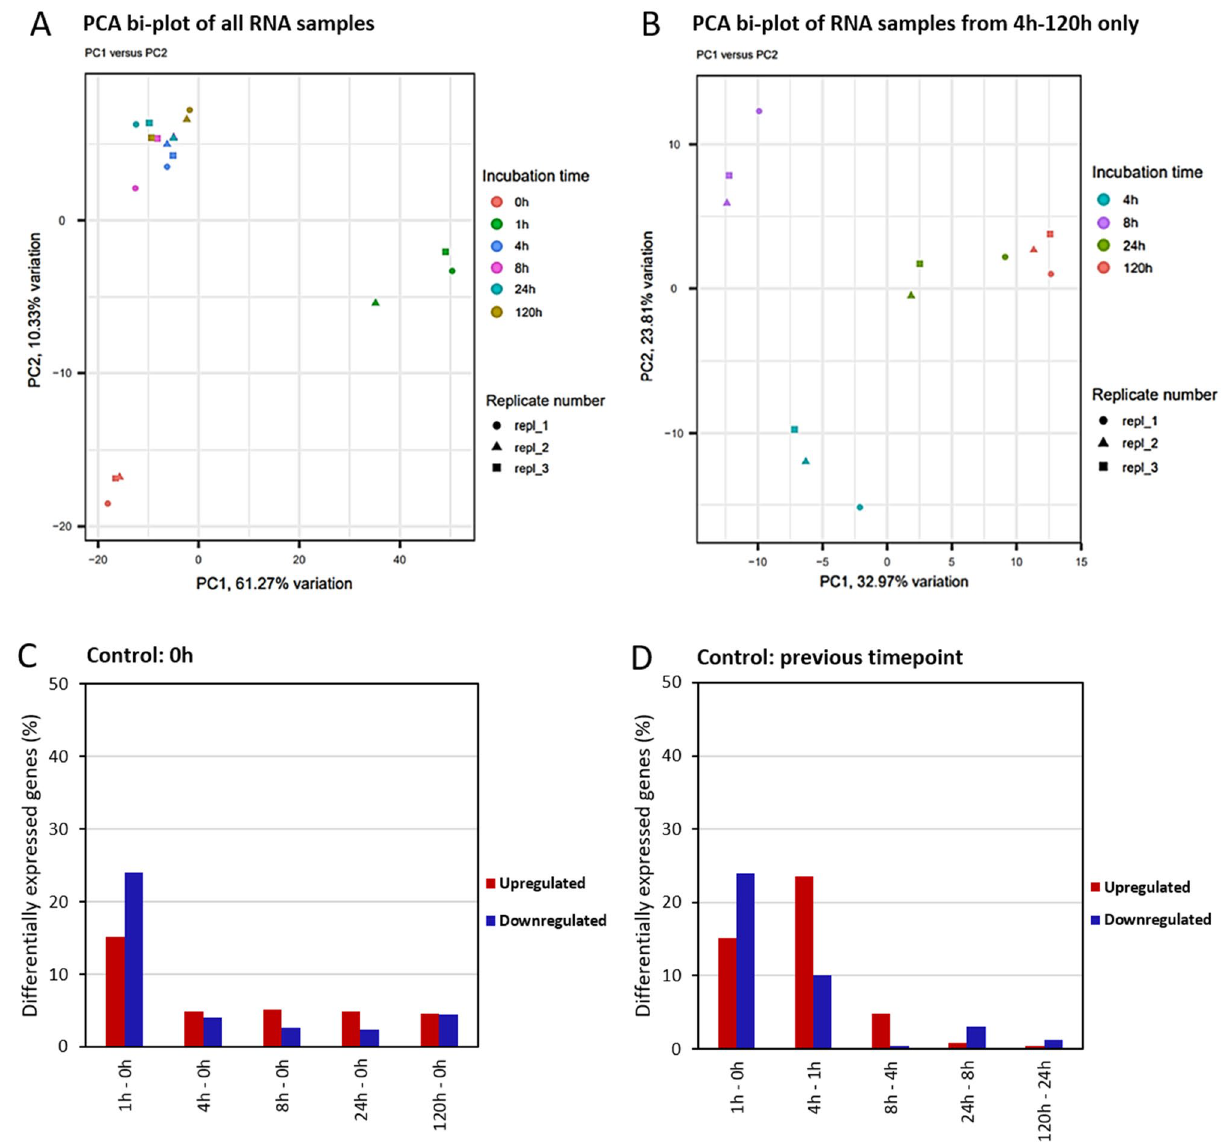
Figure 4. ( A , B ) PCA bi-plots of the RNA-Seq samples collected at 0 h, 1 h, 4 h, 8 h, 24 h and 120 h and for samples collected at 4 h, 8 h, 24 h and 120 h after the increase in temperature from 30 to 42 °C. The first two PCs are displayed. ( C , D ) Percentage of DEGs over time, observed in Picochlorum sp. (BPE23) after an increase in temperature from 30 to 42 °C. The total pool of genes was 6990. The time after temperature shift is displayed on the x-axis, as is the sampling time that was used as control. Up-regulated genes are indicated in green whereas down-regulated DEGs are indicated in red. DEGs were selected based on an FDR-adjusted p value ≤ 0.05 and an absolute log2 fold change value >